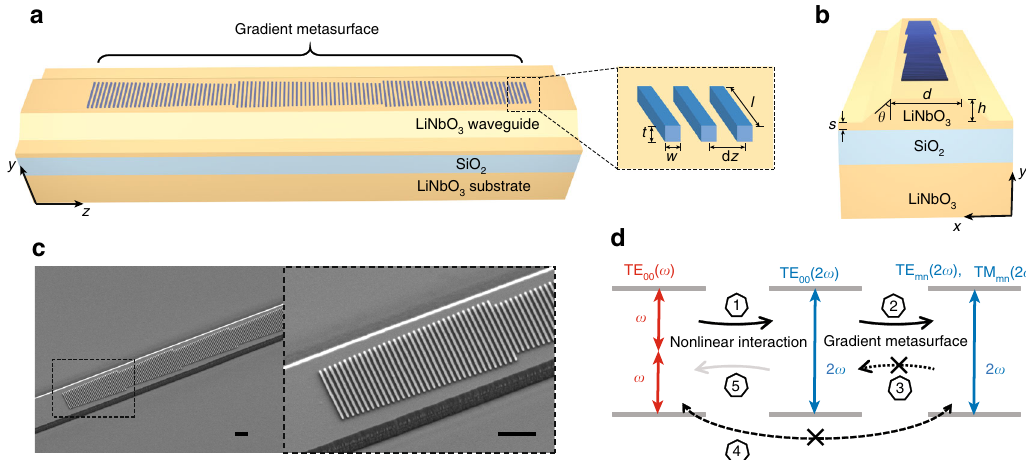
Fig. 1 Device schematics and working principle. a Schematic of an integrated nonlinear photonic device, where a gradient metasurface consisting of arrays of dielectric phased antennas is used to achieve phase-matching-free second harmonic generation (SHG) in a LiNbO 3 waveguide. For clarity, only three antenna arrays are shown, but there could be more than three arrays. Inset shows a magni fi ed view of the antenna array. b Schematic of the device cross- section. c Left: Scanning electron microscope (SEM) image of a fabricated device showing four phased antenna arrays consisting of silicon nano-rods of different lengths patterned on the top surface of a LiNbO 3 waveguide. Right: Zoom-in view of the device (dashed frame in the left image). Scale bar: 1 µ m for both images. d Conceptual diagram of the proposed phase-matching-free SHG. The optical power is fi rst coupled from the pump, TE 00 ( ω ), to the fundamental waveguide mode at the second harmonic (SH) frequency, TE 00 (2 ω ) (arrow #1 in the diagram), and then with the assistance of the gradient metasurface, coupled to the higher-order waveguide modes at the SH frequency, TE mn (2 ω ) and TM mn (2 ω ) (arrow #2). The unidirectional wavevector provided by the gradient metasurface ensures that coupling of optical power back from the TE mn (2 ω ) and TM mn (2 ω ) modes to the TE 00 (2 ω ) is highly inef fi cient (arrow #3). The coupling of optical power from the TE mn (2 ω ) and TM mn (2 ω ) modes to the pump, TE 00 ( ω ), is also highly inef fi cient (arrow #4), because the spatial overlap between TE mn (2 ω ) or TM mn (2 ω ) and TE 00 ( ω ) in the waveguide cross-section is small (i.e., coupling coef fi cient is small). In this way, asymmetric optical power transfer is realized between the pump and the SH signal (i.e., process indicated by arrow #1 is more ef fi cient than the process indicated by arrow #5) and as a result the SHG power monotonically increases as a function of the propagation distance. This new scheme circumvents the nonlinear phase-matching condition as long as the gradient metasurface provides an asymmetric effective wavevector to preferentially couple optical power from lower to higher-order waveguide modes at the SH frequency and does not interact with the